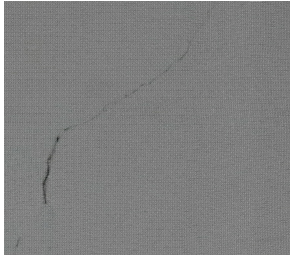
Figure 6. Point Cloud of Cracked